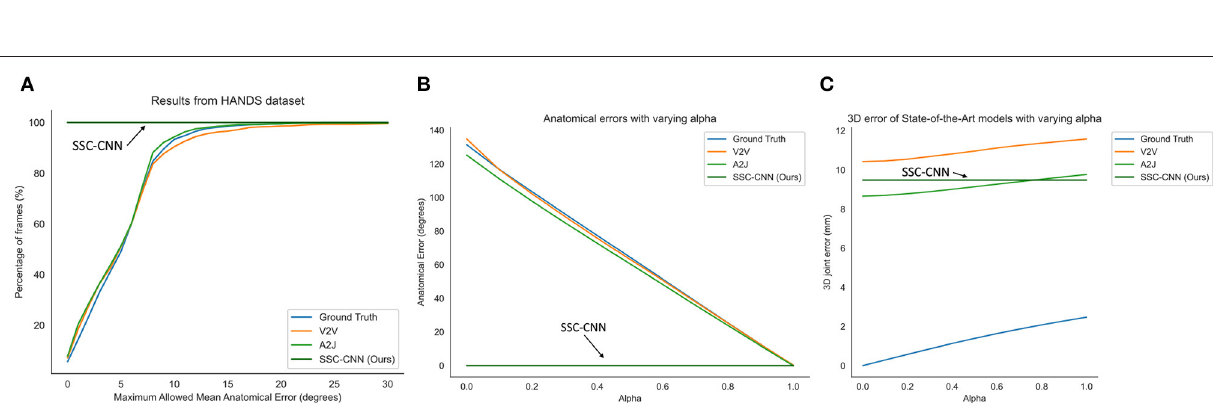
FIGURE 6 | Comparison of the anatomical errors and the 3D joint errors of various state-of-the-art models along with our proposed model using the HANDS hand dataset (A,C) . The ground truth is also shown for comparison as it has high anatomical errors (B) . This can be due to the noises during the recording of the labels.